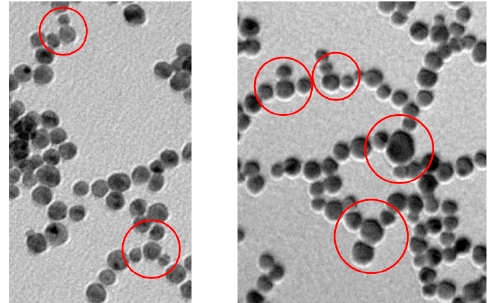
Figure 8. TEM pictures with highlighted branching points formed due to the non-linear disposition of AuNPs of small size in two different samples still mostly at the necklace-like aggregation